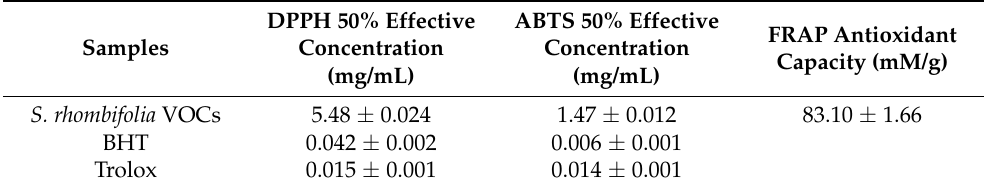
Figure 4. Percentage of the inhibitory effect of S. rhombifolia volatile organic compounds in ABTS free radical scavenging assay. Table 2. Antioxidant activities of S. rhombifolia for VOCs expressed as IC50 values (mg/mL) for DPPH, ABTS, and FRAP